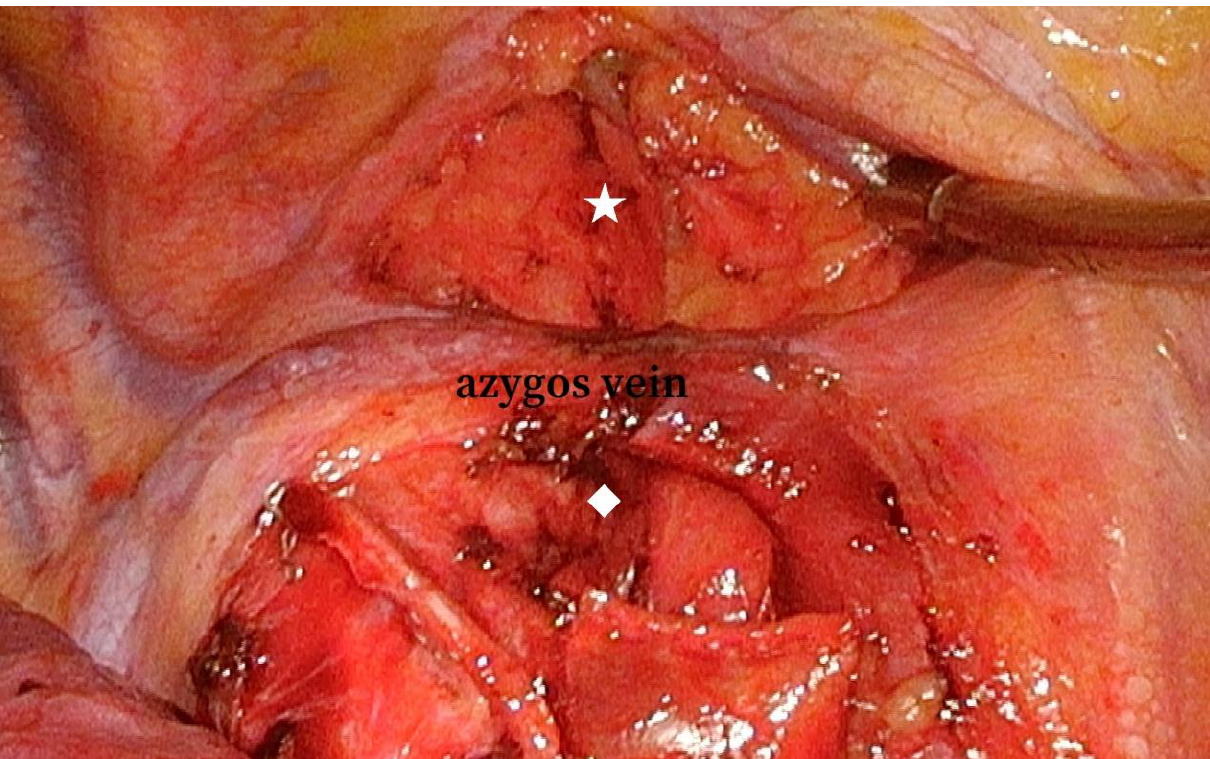
Figure 2. Lymph node stations 2 to 4. Asterisk: station 2; diamond: station 4; station 3 was between station 2 and 4 and the midline of the spine.